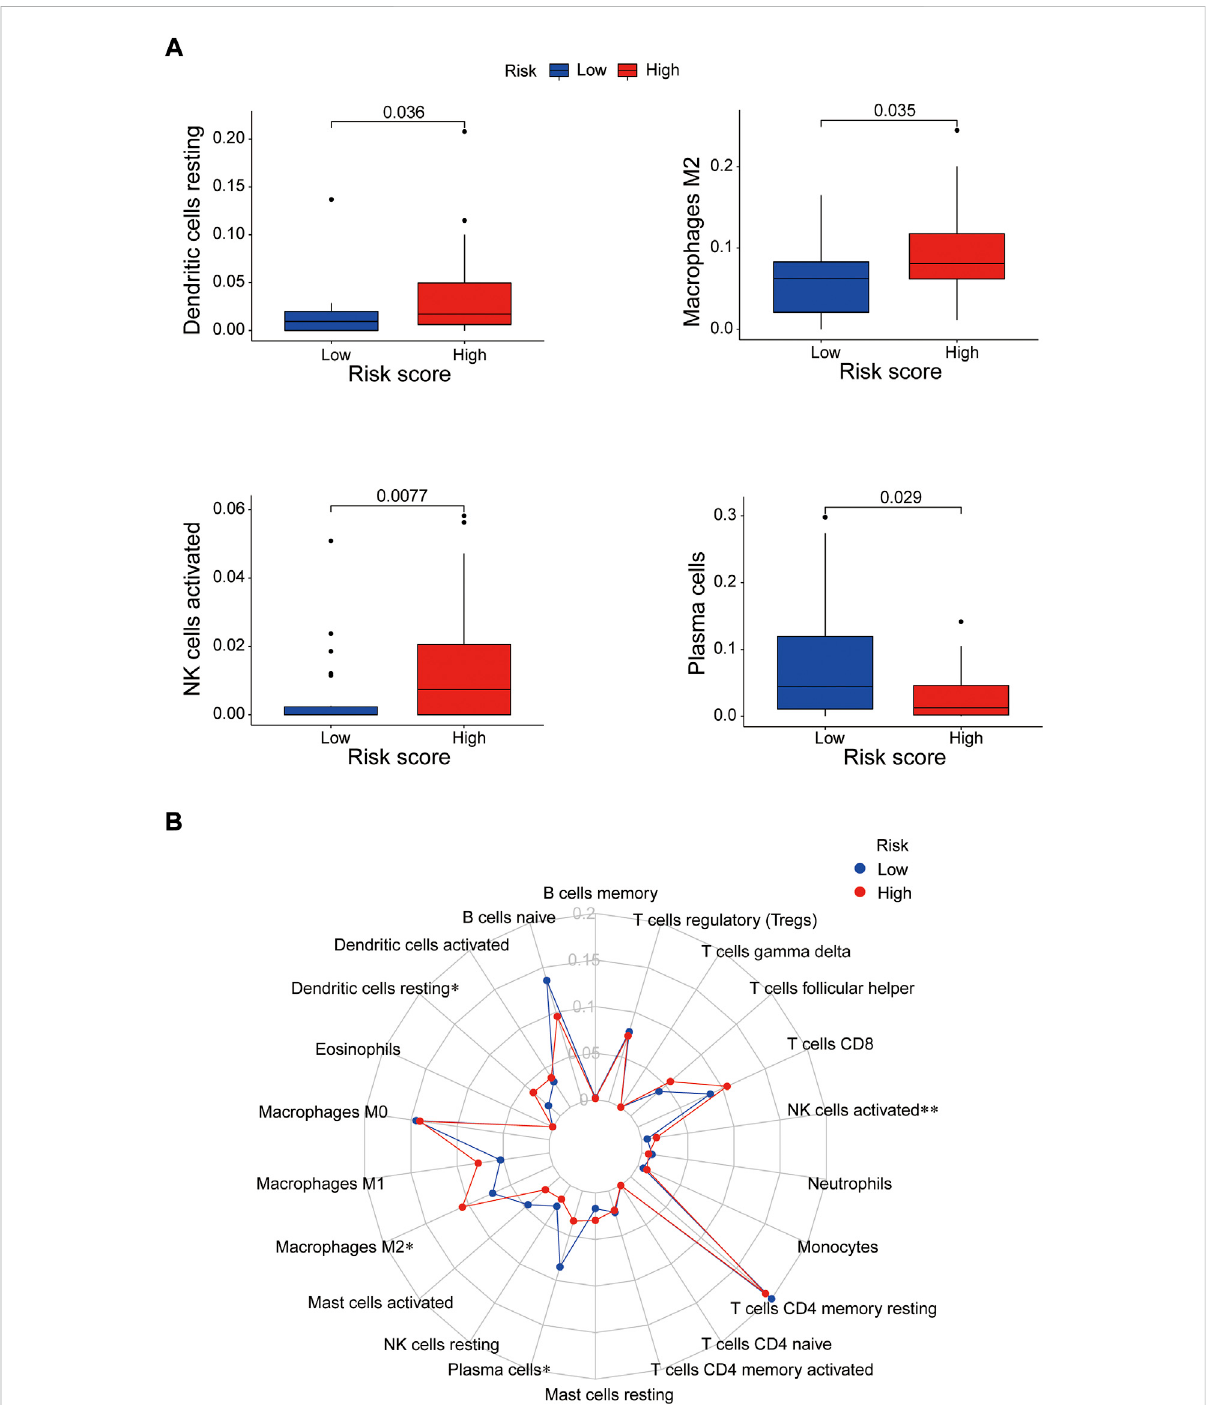
FIGURE 10 Thecorrelationbetweenimmunecellsandtheriskgroups. (A) Activatedimmunecellsinthehigh-andlow-riskgroups. (B) Radarplot.* p < 0.05; ** p <